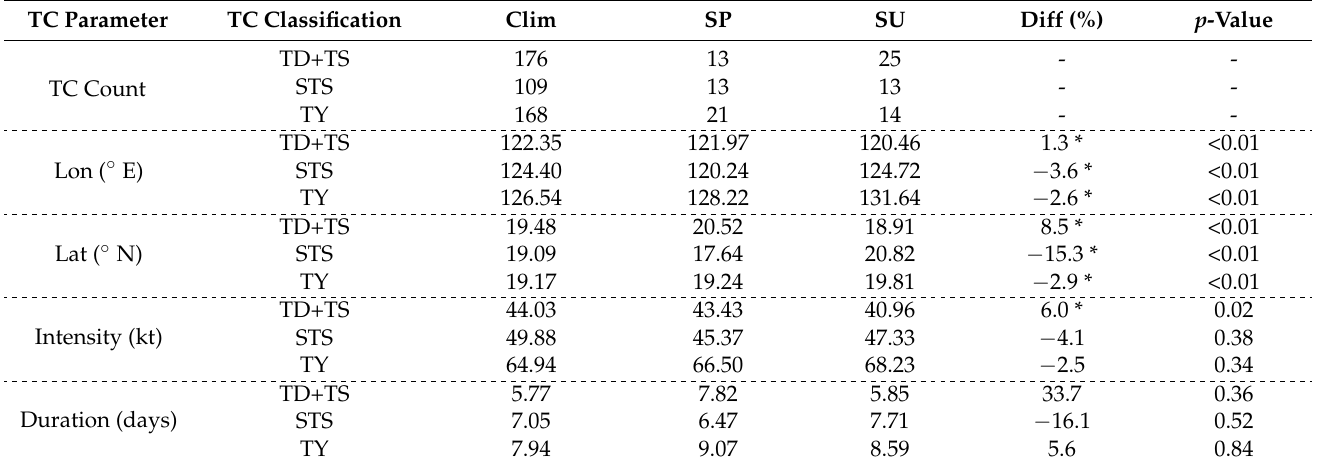
Table 2. The TC parameters of the different classifications of TCs making landfall in China during SP and SU El Niño years. The differences (sixth column) were the rates of change in SP El Niño years relative to SU El Niño years. A * indicates statistical significance at the 95% confidence level, based on the Wilcoxon–Mann–Whitney test. The p -value is the statistical significance of the last